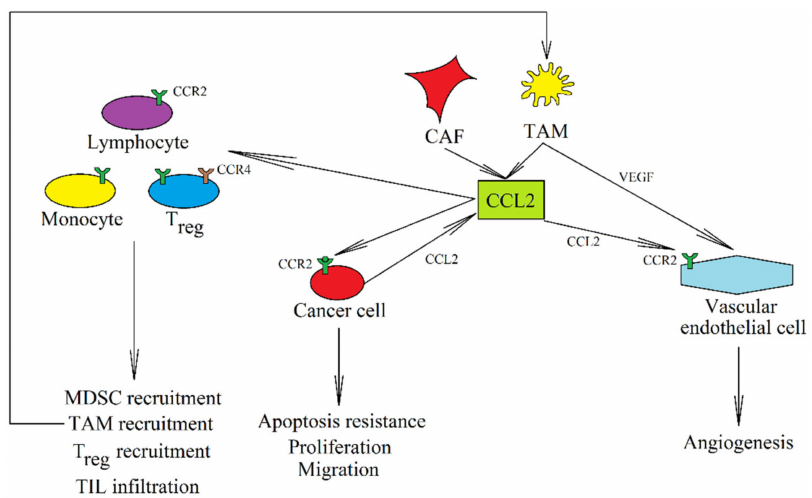
Figure 1. The role of CCL2 in caner. In a tumor, CCL2 is produced by tumor cells and by CAF and TAM. It activates its receptor, CCR2, on a tumor cell, which stimulates the proliferation of cancer cells and causes their migration and resistance to apoptosis. CCL2 also acts on non-cancer cells, e.g., activating CCR2 on vascular endothelial cells which results in angiogenesis. CCL2 causes the recruitment of MDSC, TAM, and T reg into the tumor niche but also induces the infiltration of the tumor by anti-cancer